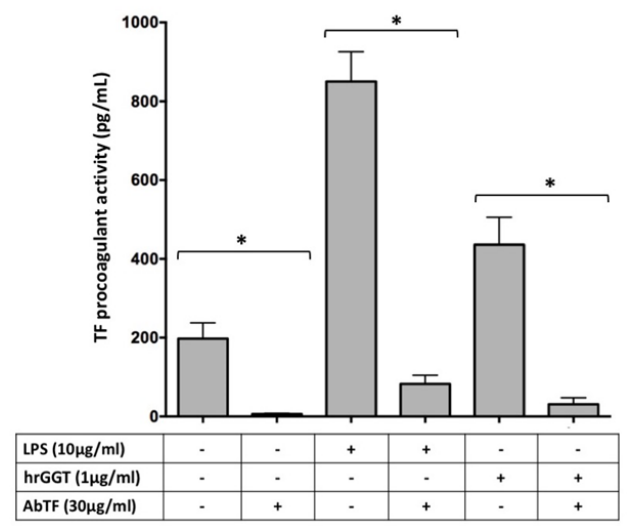
Figure 4. TF procoagulant activities measured in THP-1 cells stimulated by hrGGT (1 µg/mL) and LPS (10 µg/mL) in the presence or absence of an anti-TF antibody (30 µg/mL). Data are presented as mean ± SEM ( n = 3). * p < 0.05. The Wilcoxon test was used. To test the specificity of hrGGT in inducing TF procoagulant activity, THP-1 cells were